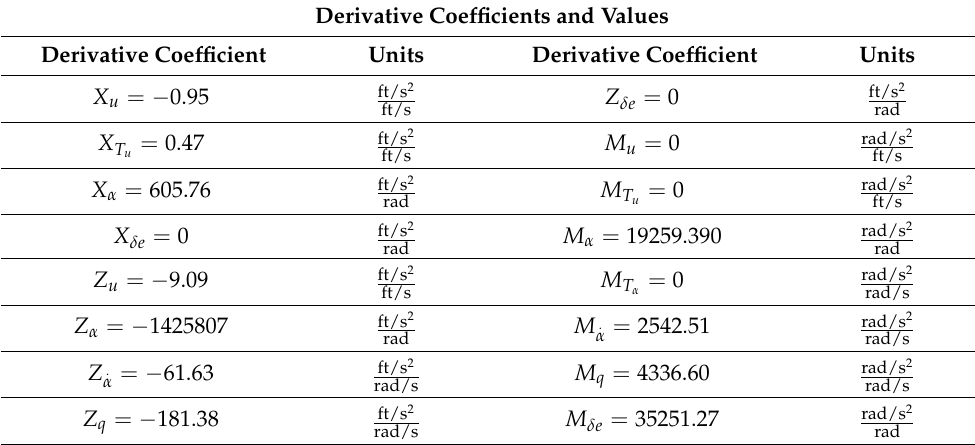
Table 3. Derivative coefficients of the Cessna-182